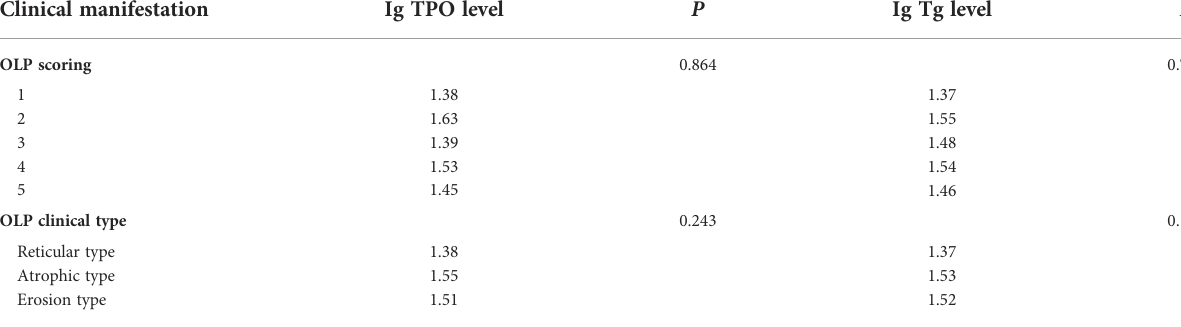
TABLE 4 Correlations between OLP clinical manifestations and the HT autoantibody levels.